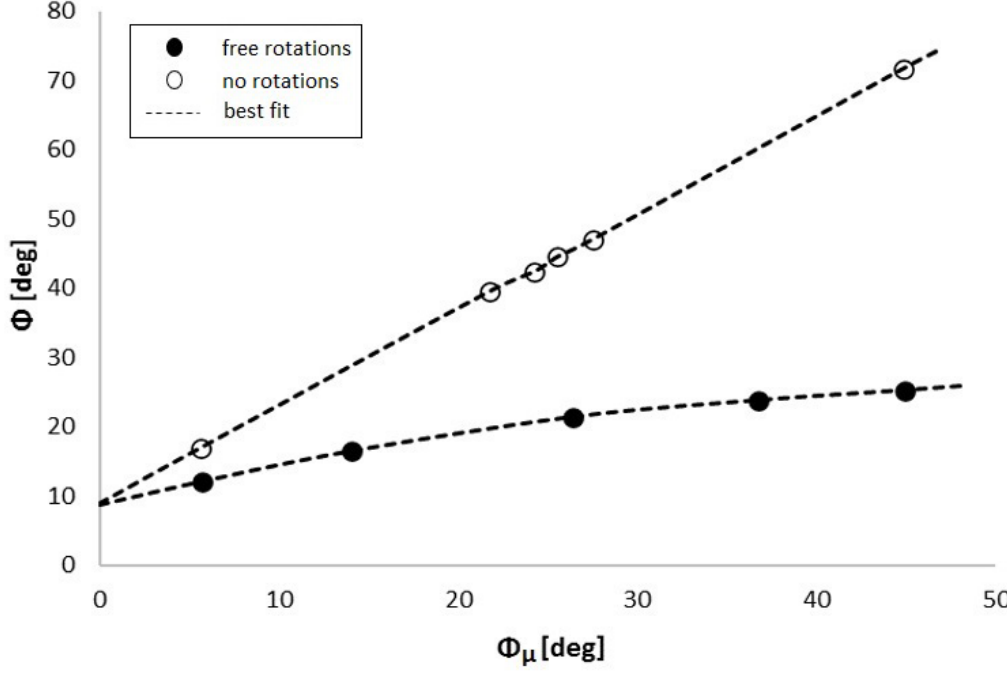
Figure 8 : Bulk friction as a function of interparticle friction: 2D DEM results (after Calvetti and Nova 2004;